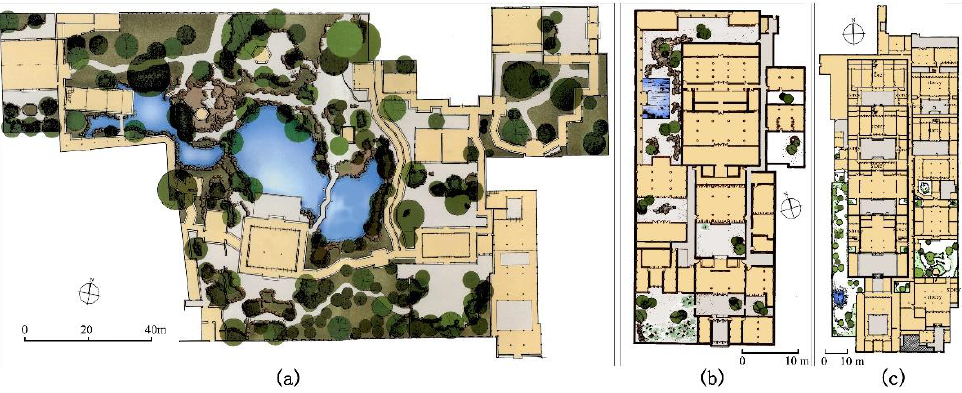
Figure 10. Three typical Qing Dynasty Suzhou gardens. ( a ) the Yi Garden. ( b ) the Qu Garden. ( c ) the Yang’s House.